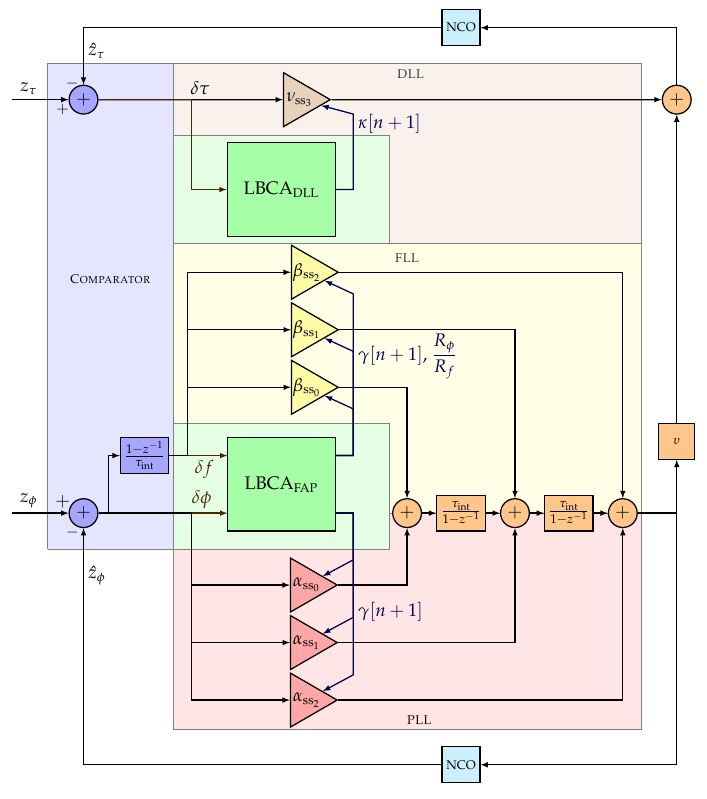
Figure 5. Adaptive full LUT-DSKF using